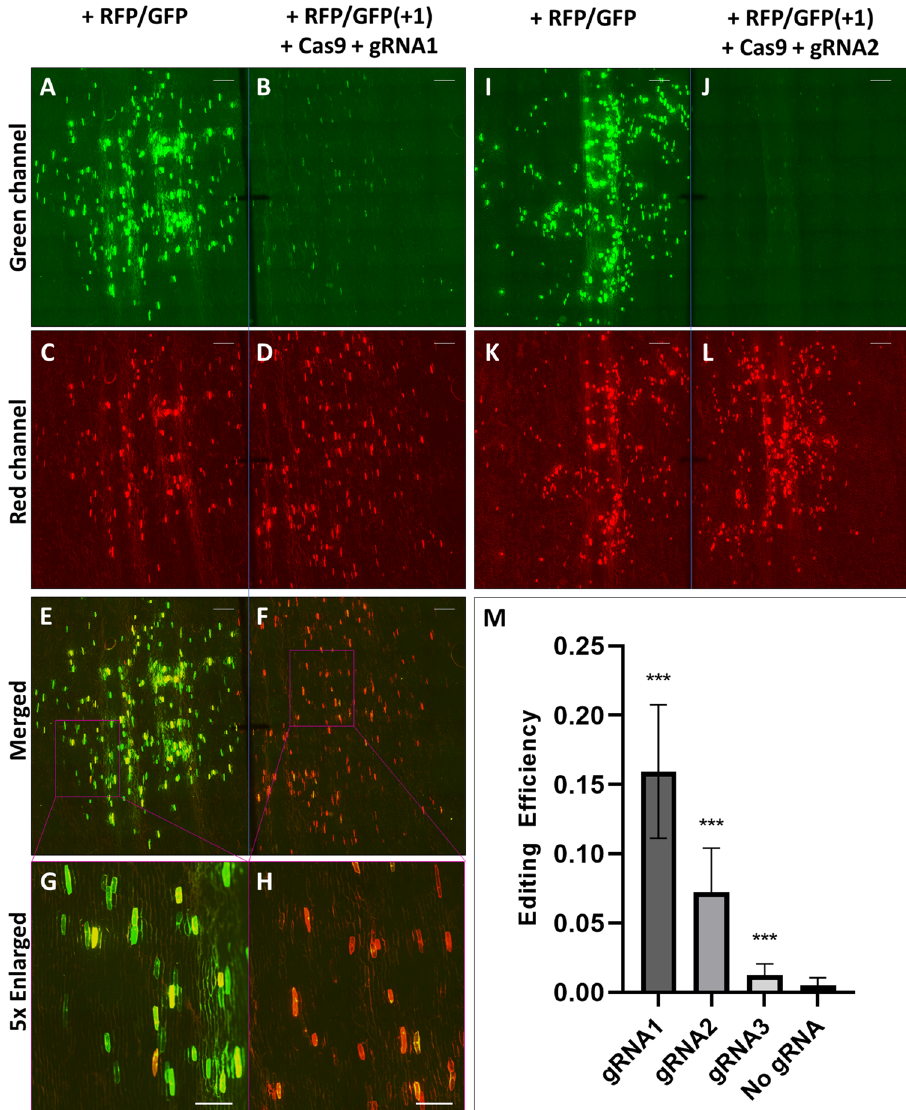
Figure 6. CRISPR-Cas9-mediated editing of a reporter plasmid. The reporter plasmid pKL2187 [(+ RFP/ GFP(+ 1)] constitutively expresses RFP but expresses GFP only if editing of the GFP leader sequence restores the correct reading frame, whereas the control plasmid pKL2188 (+ RFP/GFP) is almost identical to pKL2187 except that GFP is expressed without editing. A representative onion sample bombarded on the left side ( A , C , E , G , I , K ) with plasmid pKL2188 as a positive control, and on the right side with the mixture of reporter plasmid pKL2187 and a CRISPR plasmid carrying either perfect match gRNA1 ( B , D , F , H ) or one nucleotide mismatch gRNA2 ( J , L ); ( M ) graph showing editing efficacy on onion samples for all gRNAs tested and a negative control, all relative to the pKL2188 positive control. Scale bar for ( A – F , I–L ) is 4 mm, ( G , H) is 2